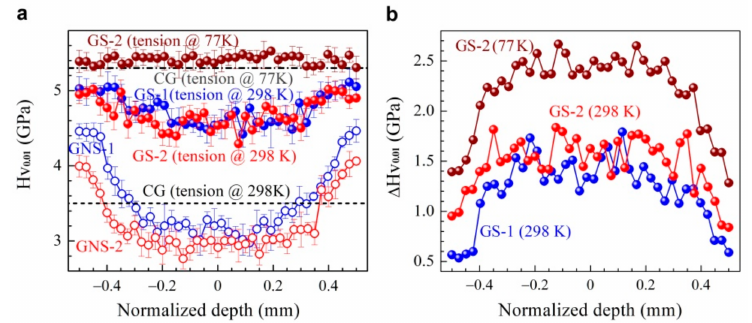
Figure 5. ( a ) The micro-hardness distributions along the depth for the GS1 and GS2 samples, prior to tensile testing (GS1 and GS2) and after tensile testing at both room temperature (GS1 and GS2) and cryogenic temperature (GS2), in which the average hardness in the CG sample is marked as a black dash line and a dash-dot line after tensile testing at both room and cryogenic temperatures. ( b ) The hardness increment distributions along the depth for the GS1 and GS2 samples after tensile testing at both room temperature (GS1 and GS2) and cryogenic temperature